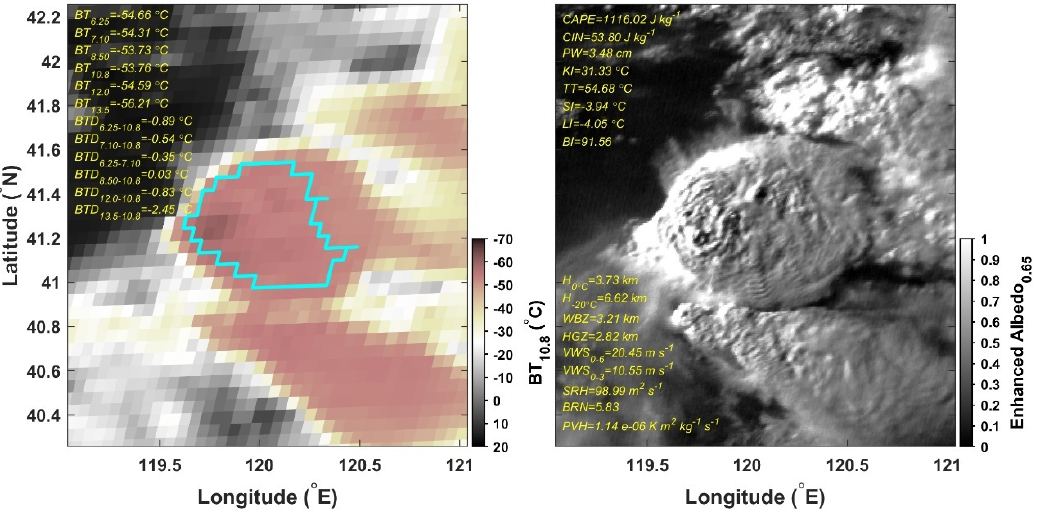
Figure 3. The satellite images showed a hailstorm sample at 09:53 (UTC) on 6 June 2018. The left image is the 10.8 μ m channel image, and the cyan polygon draws the identified boundary of the hailstorm. The right image is the 0.65 μ m channel image which is enhanced to display the texture of the cloud top. The yellow texts in both images record the 29 features of this hailstorm sample.